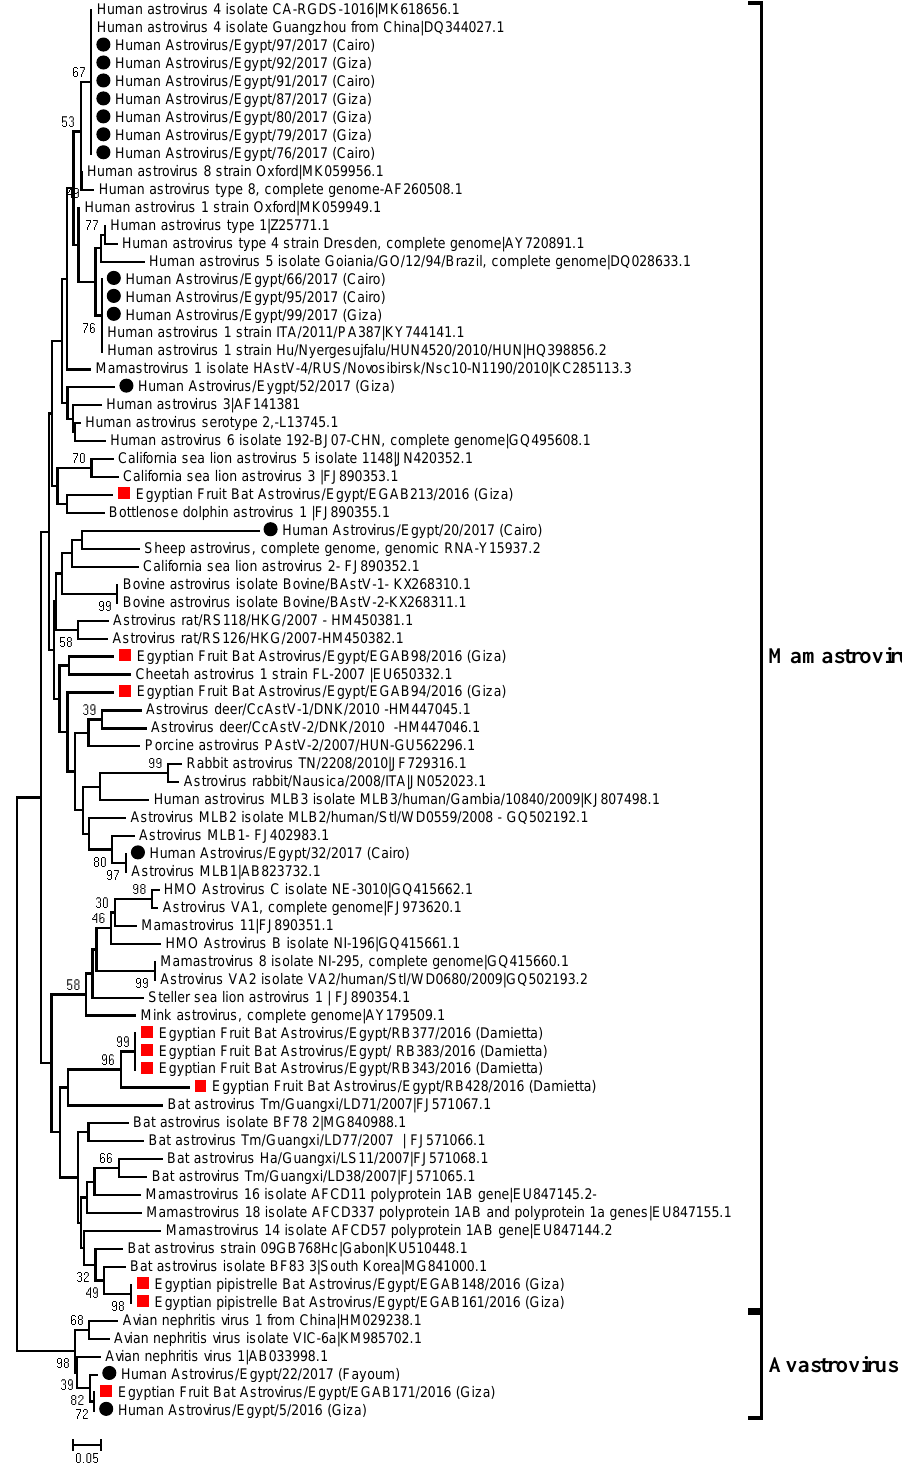
Figure 1. Neighbor joining phylogenetic tree of 422 bp of RNA-dependent RNA polymerase gene of the detected astroviruses in human and bat samples. Geographical sampling locations were indicated in the tree. Human and bat Astroviruses sequenced specifically for this study are labeled with black circles and red squares, respectively. The percentage of replicate trees in which the associated taxa clustered together in the bootstrap test (1000 replicates) is shown at the dendrogram nodes. The phylogenetic analysis was performed by using MEGA version